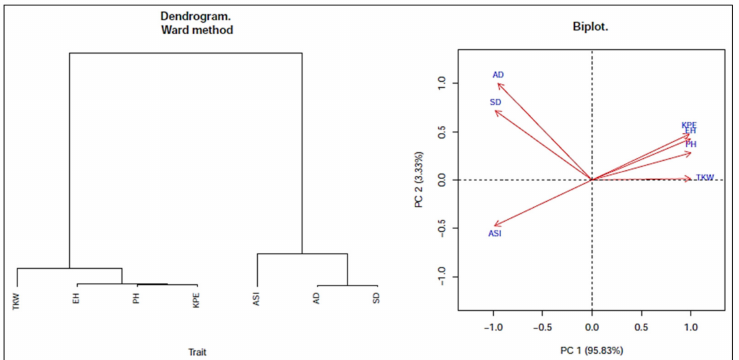
Figure 3. Dendrogram showing clustering of different traits ( left ); position of different traits depicted on biplot from principal component analysis of combined data.